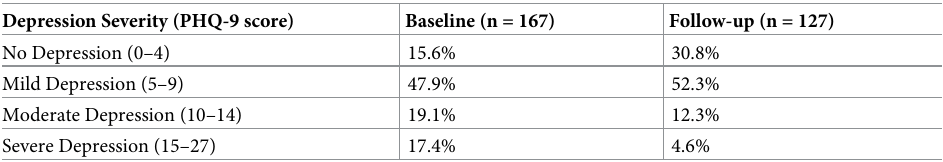
Table 2. Depression severity of participants at baseline and 3